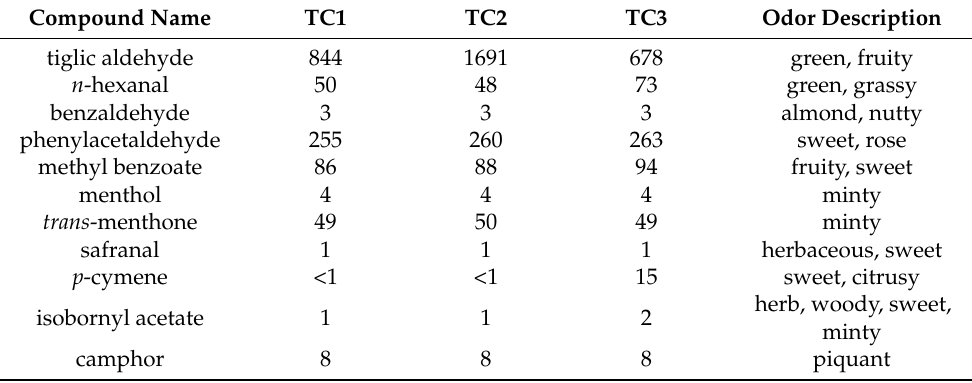
Table 4. Odor activity values of the most relevant volatile constituents in commercial samples (TC1-TC3) and odor descriptions reported in the